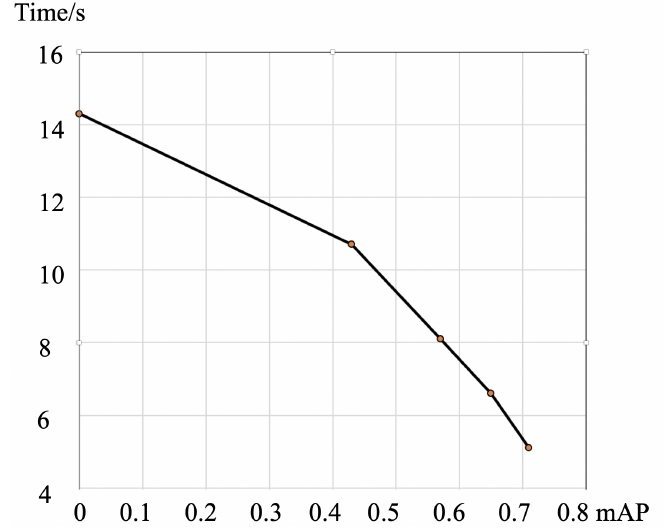
Figure 13. The relationship between different mAPs of the auxiliary net with cost time. The y-axis is the annotation time and the x-axis is the mAP of different proposal networks.